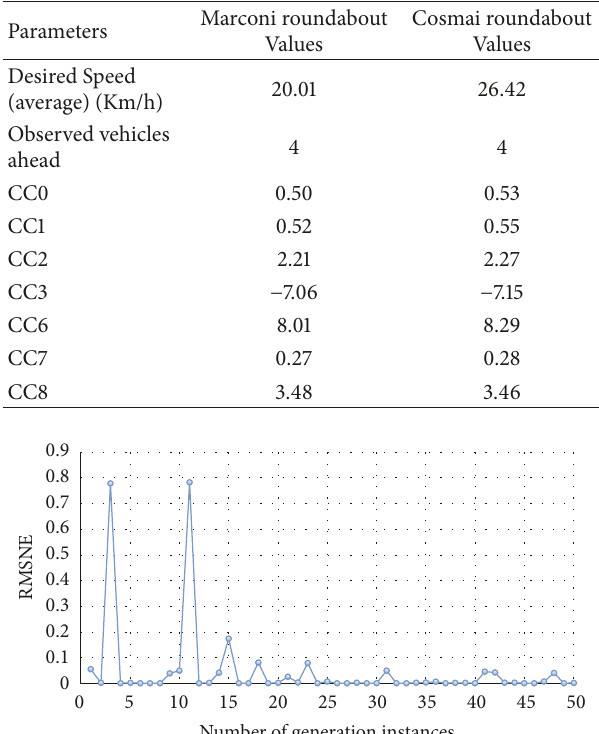
Table 7: Best estimate of factors obtained from the generational genetic algorithm.